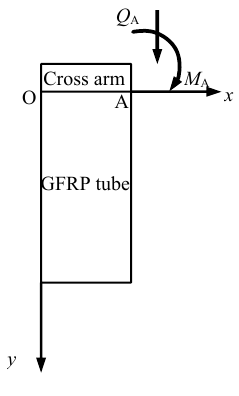
Figure 11. Half beam model.